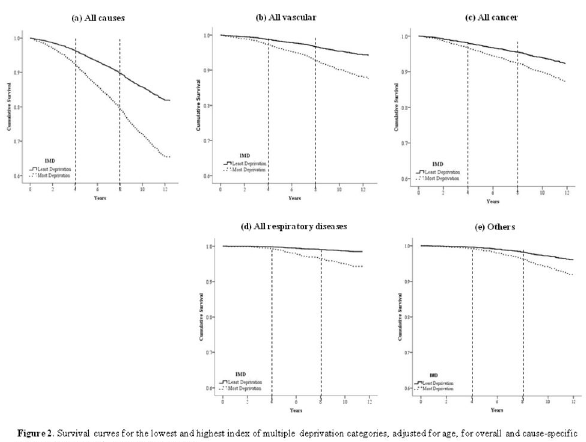
Figure 2. Survival curves for the lowest and highest index of multiple deprivation categories, adjusted for age, for overall and cause-specific mortality in the BWHHS, 1999-2001 to 2012. (a) All-cause, (b) all vascular, (c) all cancer, (d) all respiratory disease and (e) others. The Y-axes were truncated to 0.6 for a better visualization. The dashed lines divide the graphs into periods of four